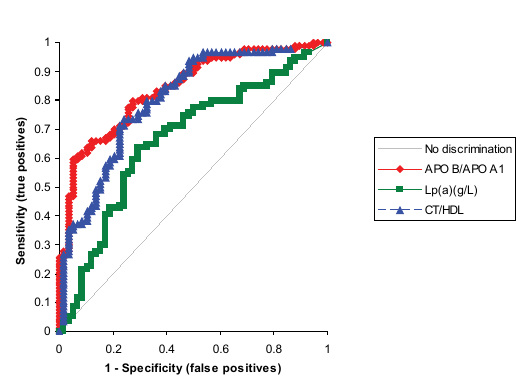
Figure 1. Receiver-operating characteristic curves for the prediction of coronary heart